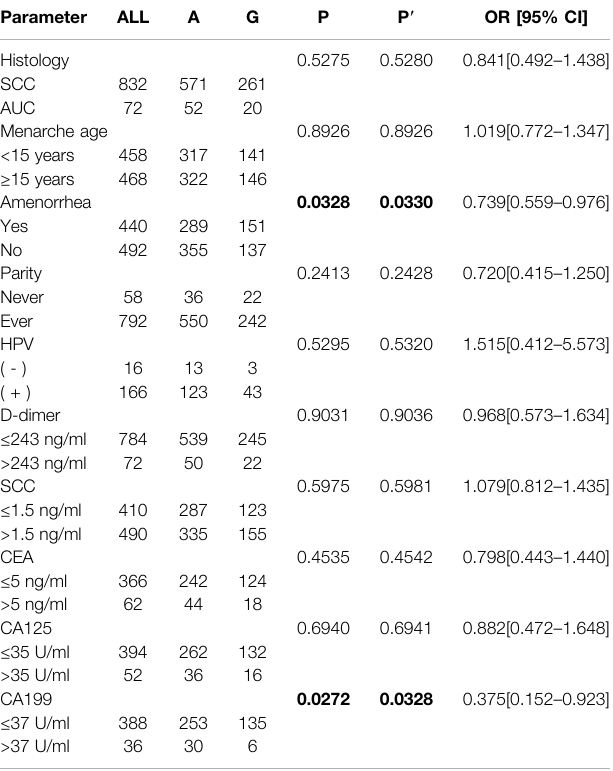
TABLE 8 | Comparison ofallele distribution frequencies with clinical parametersin the CC group. Parameter